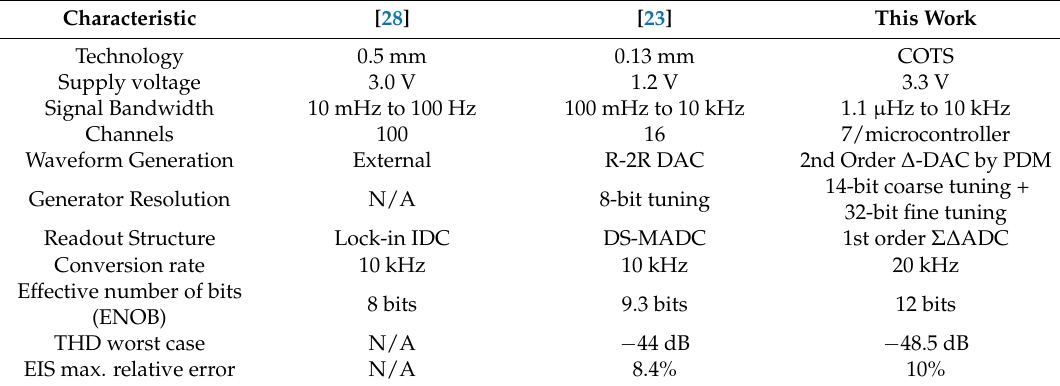
Table 1. Comparative analysis. EIS: Electrochemical impedance